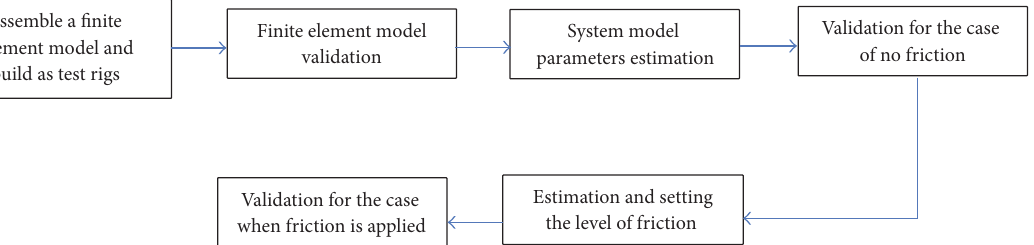
Figure 11: Experimental design and validation steps.